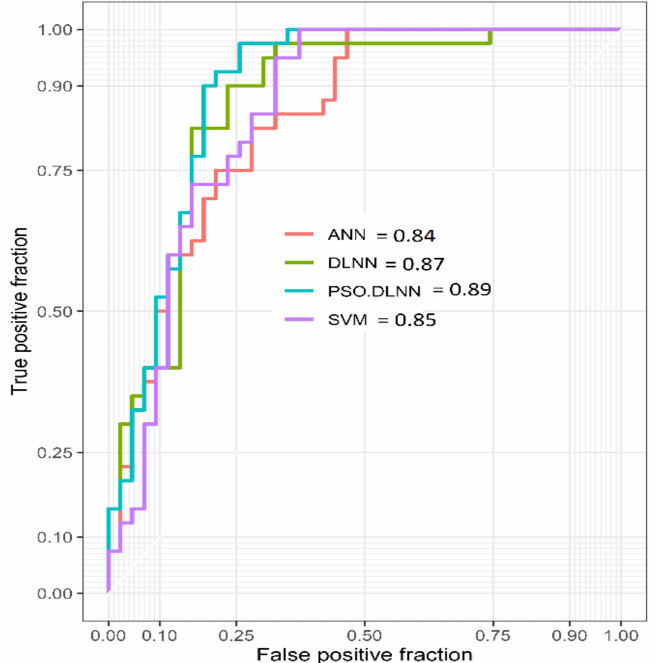
Figure 9. Receiver operating characteristic (ROC) curve analysis for four head-cut gully erosion models using the testing dataset. Table 5. Predictive capability of guully erosion susceptibility (GES) models using training and testing datasets.